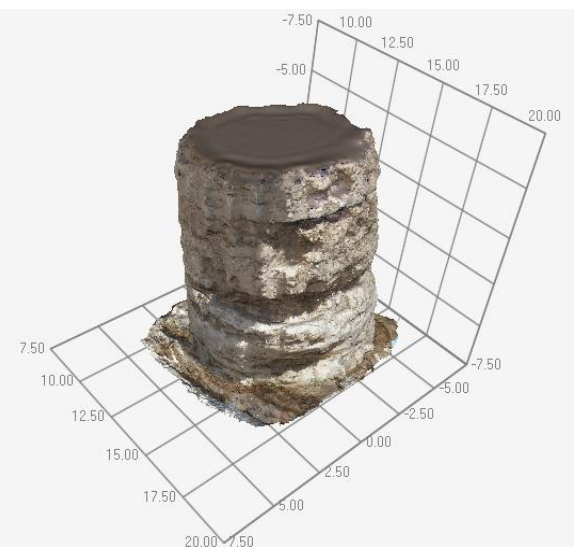
Figure 16. 3D model of the Temple of Neptune